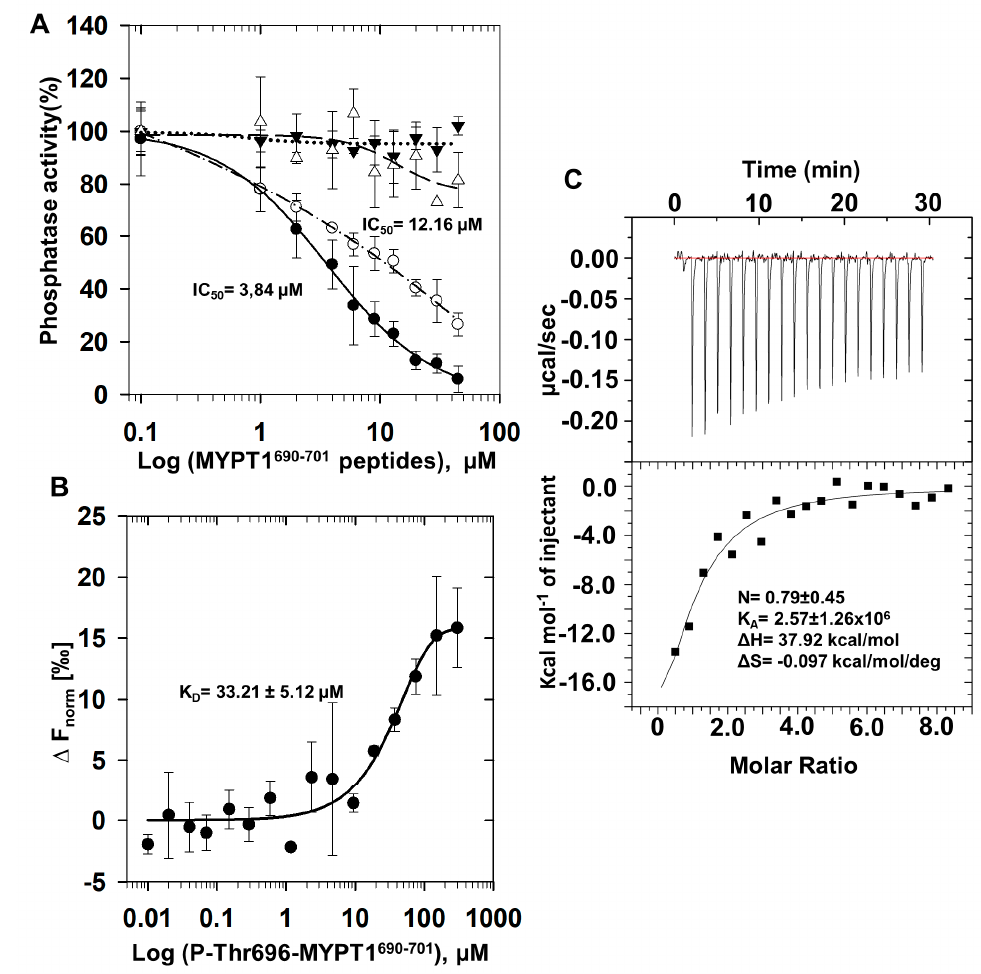
Figure 2. Effects of a phosphorylated peptide from MYPT1 on the activity of PP1c, PP2Ac and myosin phosphatase holoenzyme (Flag ‐ MYPT1 ‐ PP1c). ( A ): The native catalytic subunit of PP1 (PP1c; ▼ , ● ) or PP2A (PP2Ac; ∆ ) purified from rabbit skeletal muscle or Flag ‐ MYPT1 ‐ PP1c overexpressed and isolated from tsa201 cells ( ○ ) was assayed in the presence of dephosphorylated ( ▼ ) or phos ‐ phorylated ( ○ , ● , ∆ ) MYPT1 peptide of R 690 QSRRS(pT696)QGVTL 701 (P ‐ Thr696 ‐ MYPT1 690 − 701 ) with 32 P ‐ MLC20 substrate as described in Materials and Methods. Values are mean ± SD (n = 4). Phosphatase